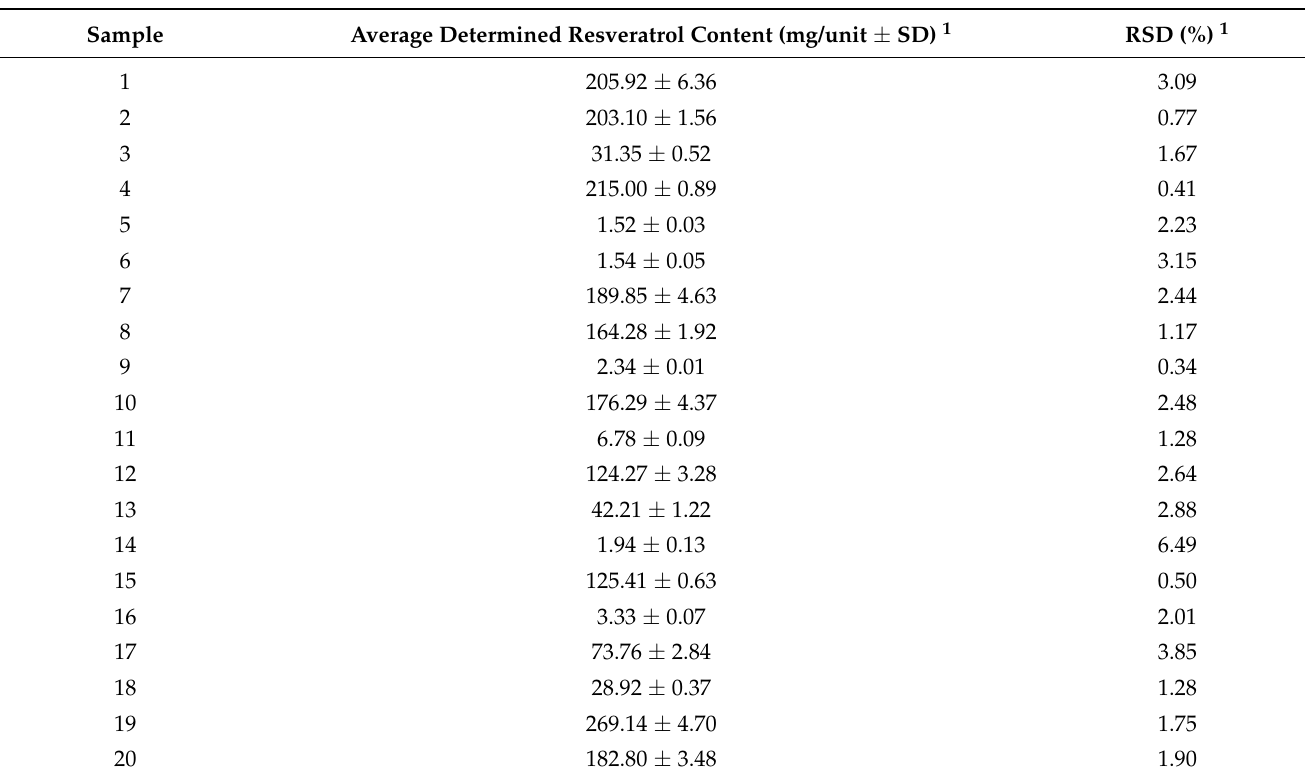
Table 2. Average resveratrol content (mg/unit ± SD) determined in 20 food supplements.